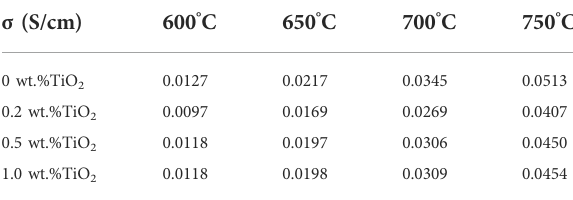
TABLE 2 Ideal electrical conductivity of SDC-xT between 600 – 750 ° low frequency region corresponds to the gas-phase diffusion process and dissociation-adsorption process. As shown in Figure 5, the polarization resistance of Pt at 650 – 750 ° C in the TiO 2 -doped electrolyte is smaller than that of the